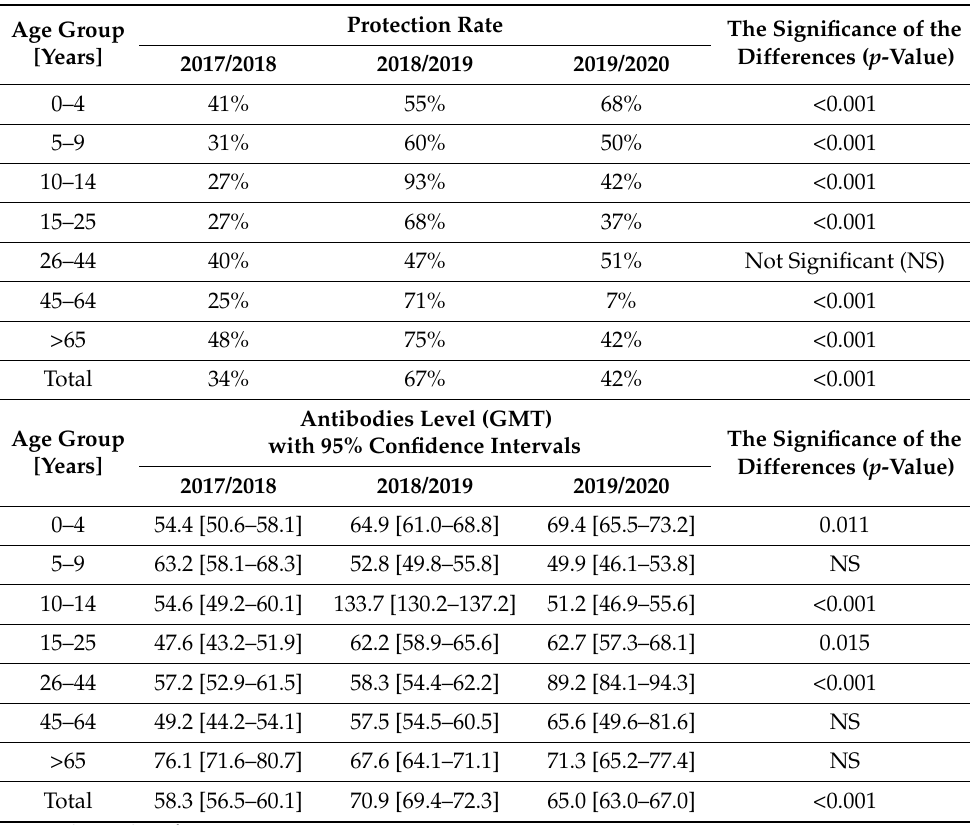
Table 1. Comparison of three epidemic seasons for B/Phuket/3073/2013—Yamagata